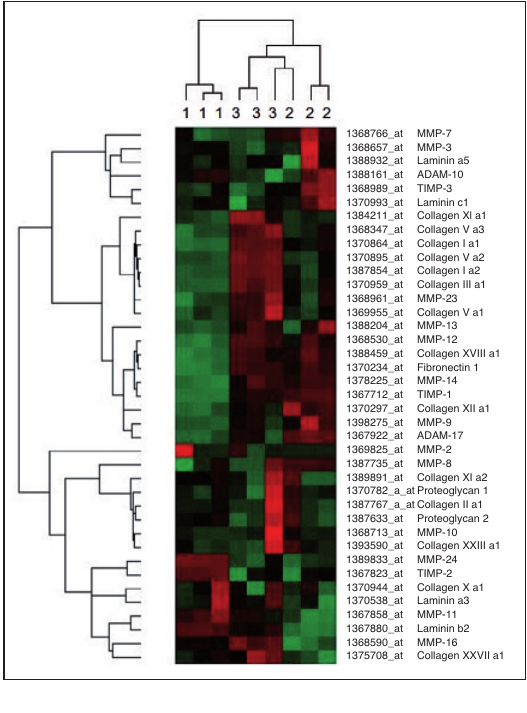
Rat heart MMP-2 mRNA expression and overall MMP activity. (a) MMP-2TaqMan qRT-PCR showed a significant increase of MMP-2 mRNA expression in DA allografts compared with DA healthy native control hearts. (b) Fluorometry from total protein extractions showed a signifi- cant, almost two-fold increase in overall MMP activity in DA allografts compared with the DA healthy native control hearts. (c) Zymography demonstrated increased pro-MMP-9 in un- treated DA grafts (lane 2) compared with DA healthy native control hearts (lane 1). Pro-MMP- 9 was significantly reduced by CsA treatment (lane 3). Purified MMP-9 was used as positive control (lane C). *p<0.05 compared to the DA healthy native hearts; # p <0.05 compared to the DA grafts CsA-treated; n = 6 per